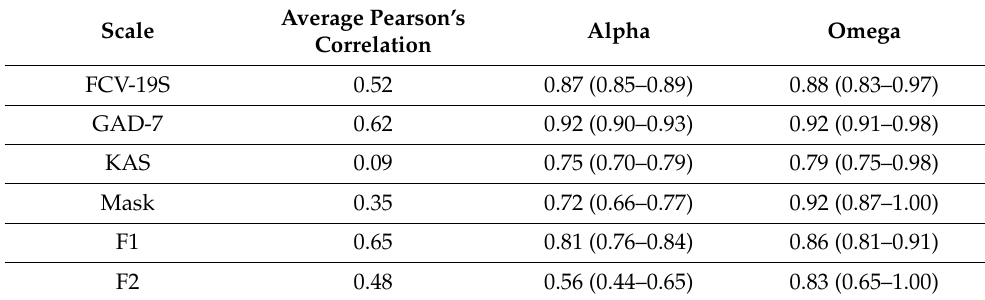
Table 1. Results of reliability